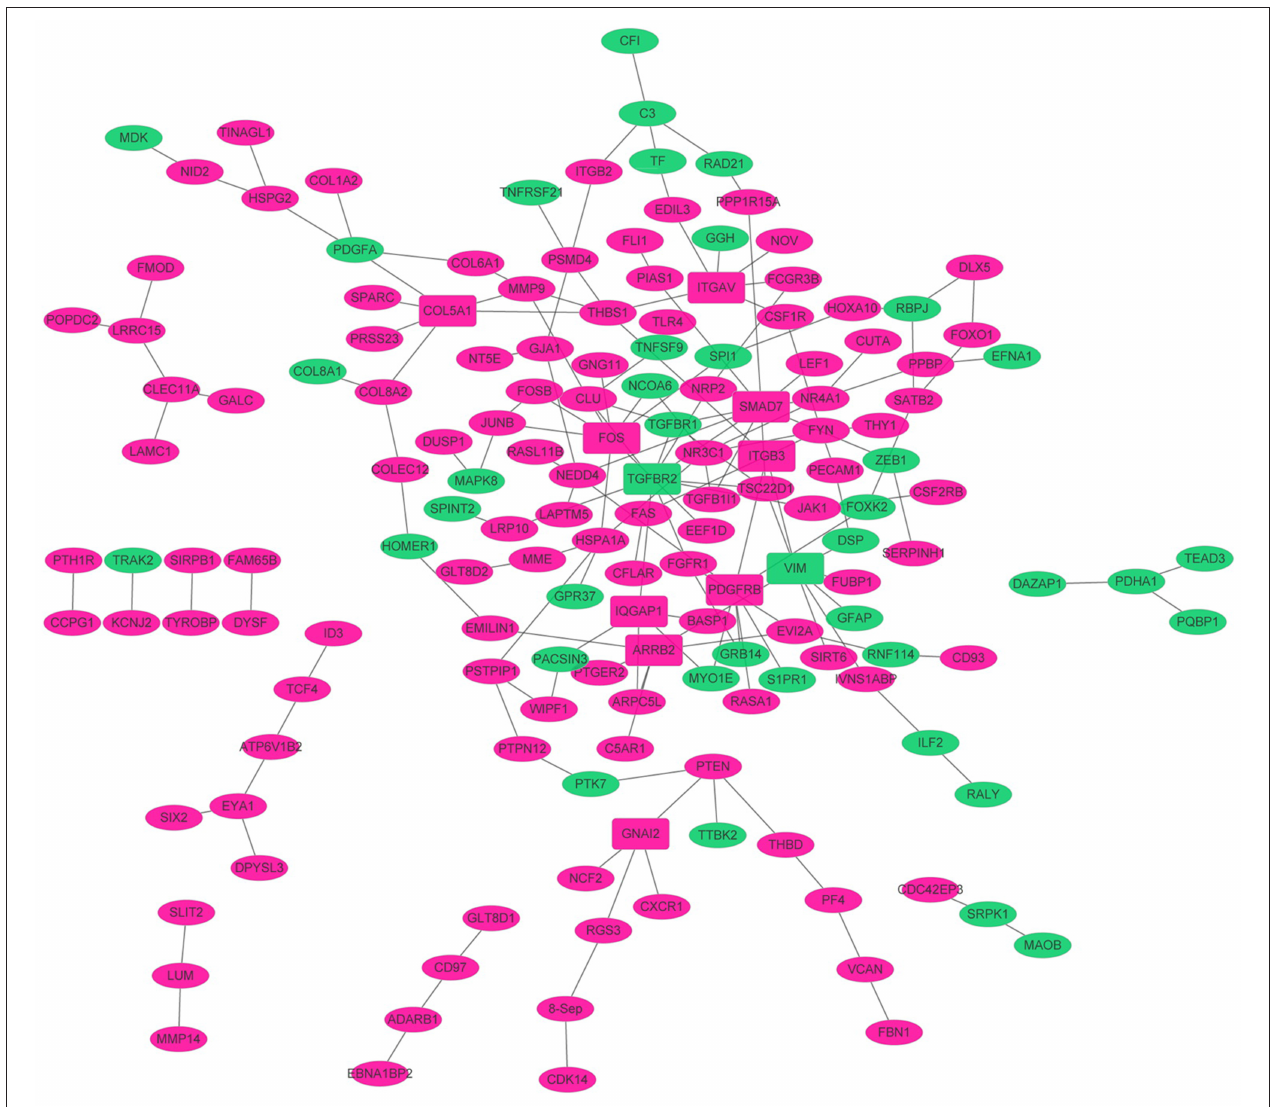
FIGURE 3 | The PPI networks. The node denoted protein, and the edge denoted the interactions. The rose red and green ellipse presented the up- and down-regulated proteins encoded by genes, respectively. The rectangle presented high degree (degree > 5) proteins encoded by DEGs. The solid line and dotted line presented direct interaction and colocalization,